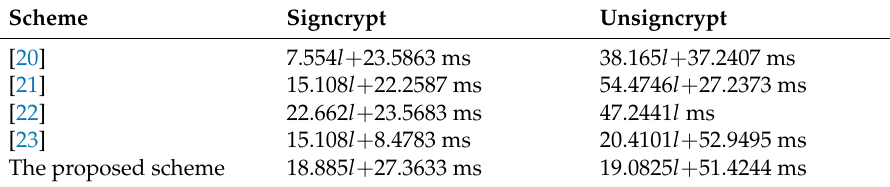
Table 3. Comparison of computation